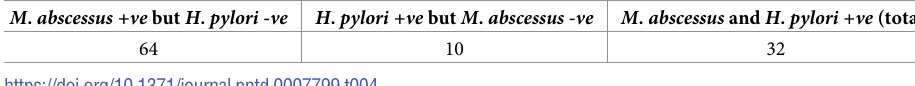
Table 4. Prevalence of co-infection of M . abscessus and H . pylori in Trivandrum. M . abscessus +ve but H . pylori -